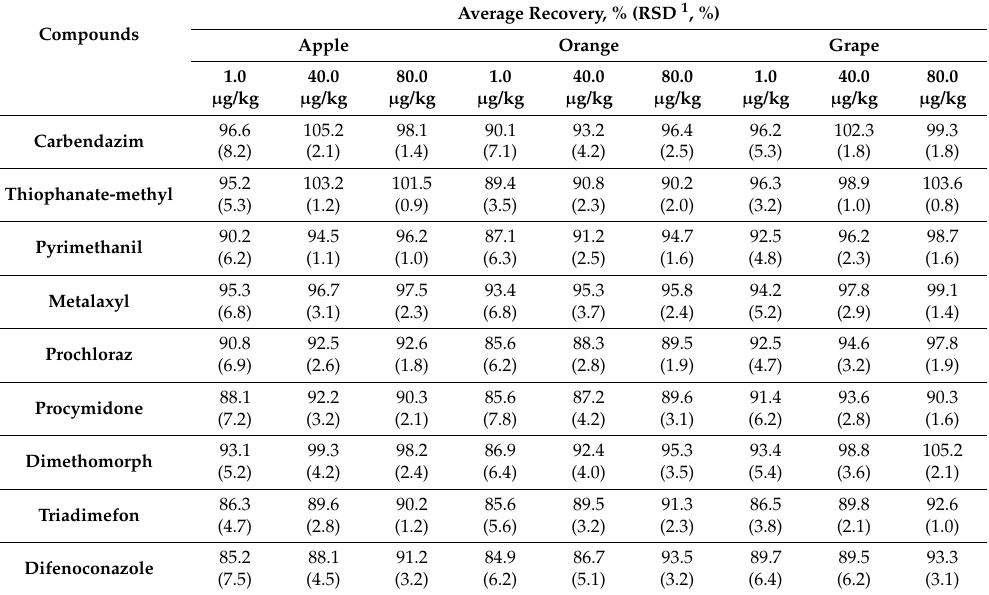
Table 4. Accuracy and precision of nine fungicides in three blank representative fruit samples spiked at three different concentrations by the developed method ( n = 6, x ± s). Average Recovery, % (RSD 1 , %) Compounds Apple Orange